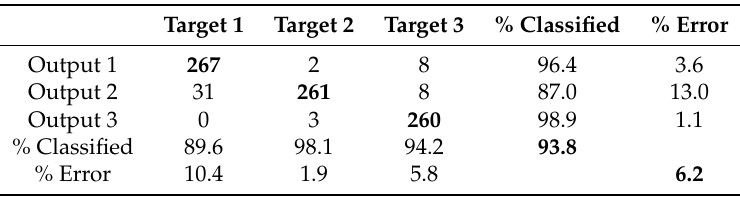
Table 7. Sample of a confusion matrix from